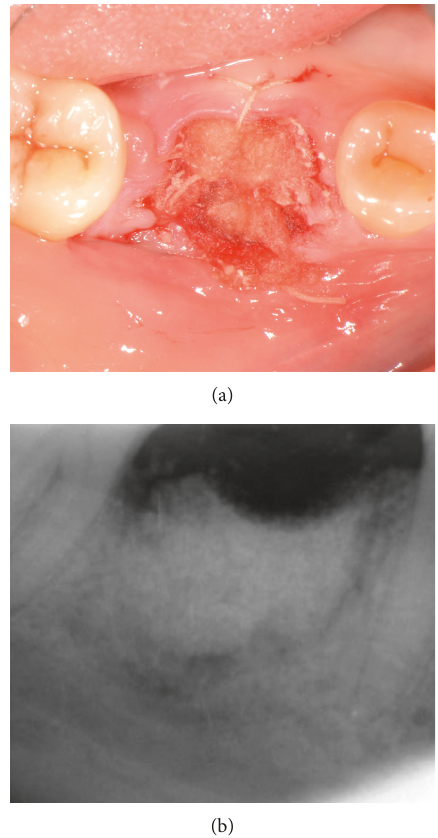
Figure 4: Clinical view and periapical X-ray of the grafted site.